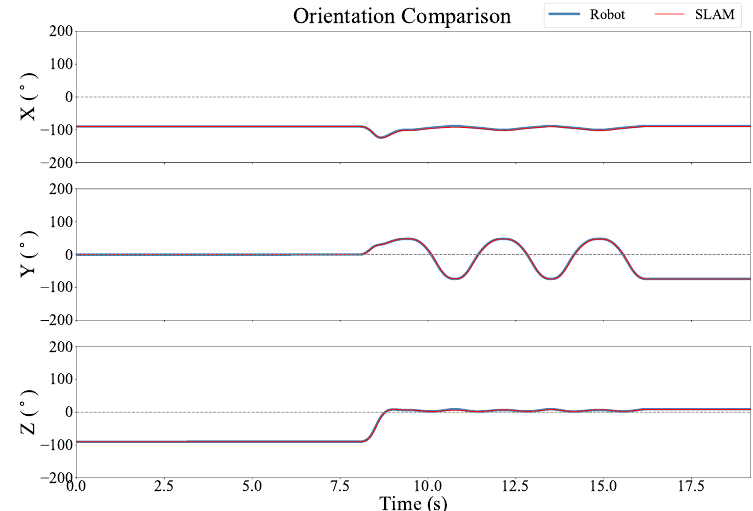
Figure 8. Euler angles versus time for each axis in the Robot Arm coordinate frame. Table 1. Position (Euclidan distance) and Orientation errors as compared to the robotic arm. Trial Position (mm) Orientation ( ◦ )